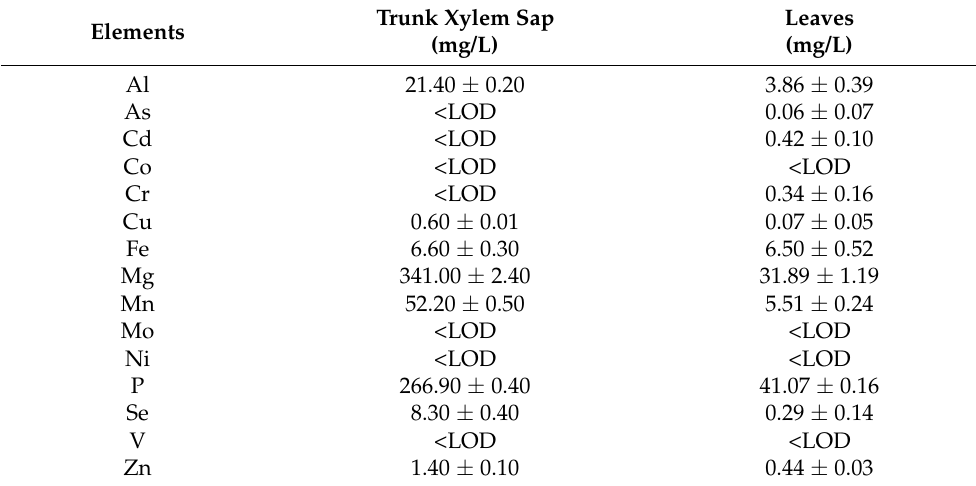
Table 2. Concentrations of elements in trunk xylem sap and leaves of D. alata .